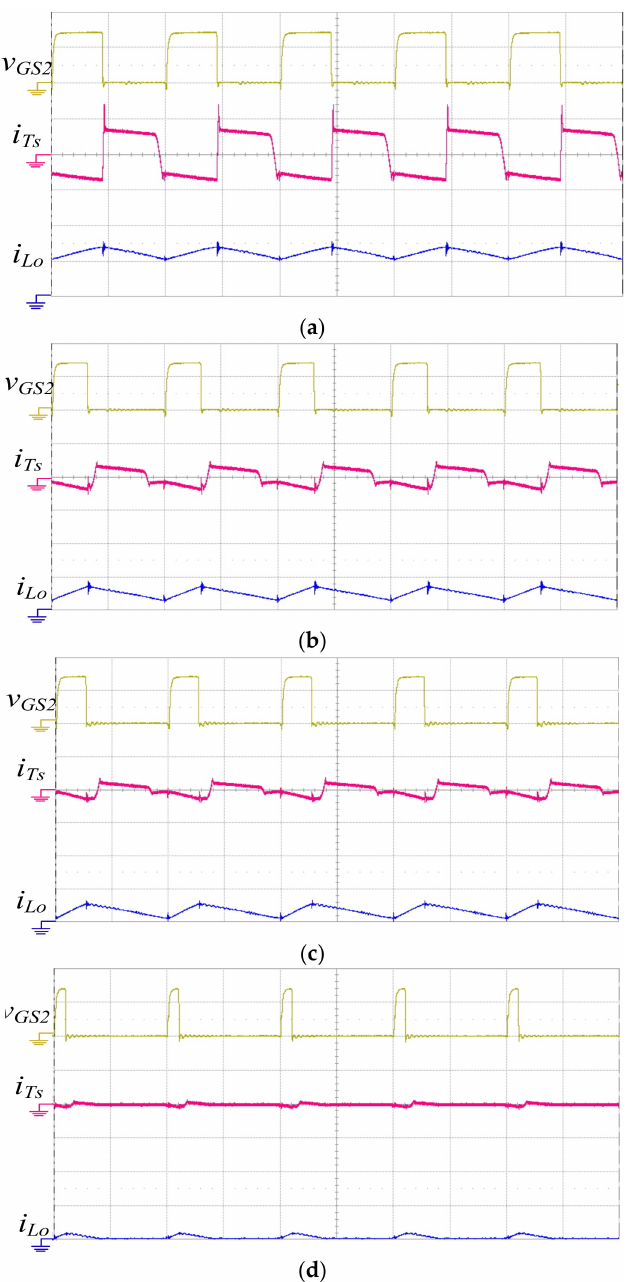
Figure 8. Waveforms of v GS2 , i Ts , and i Lo at ( a ) 100%, ( b ) 50%, ( c ) 25%, and ( d ) 4% rated power. ( v GS2 : 10 V / div, i Ts : 2 A / div, i Lo : 1 A / div, Time: 10 µ s /